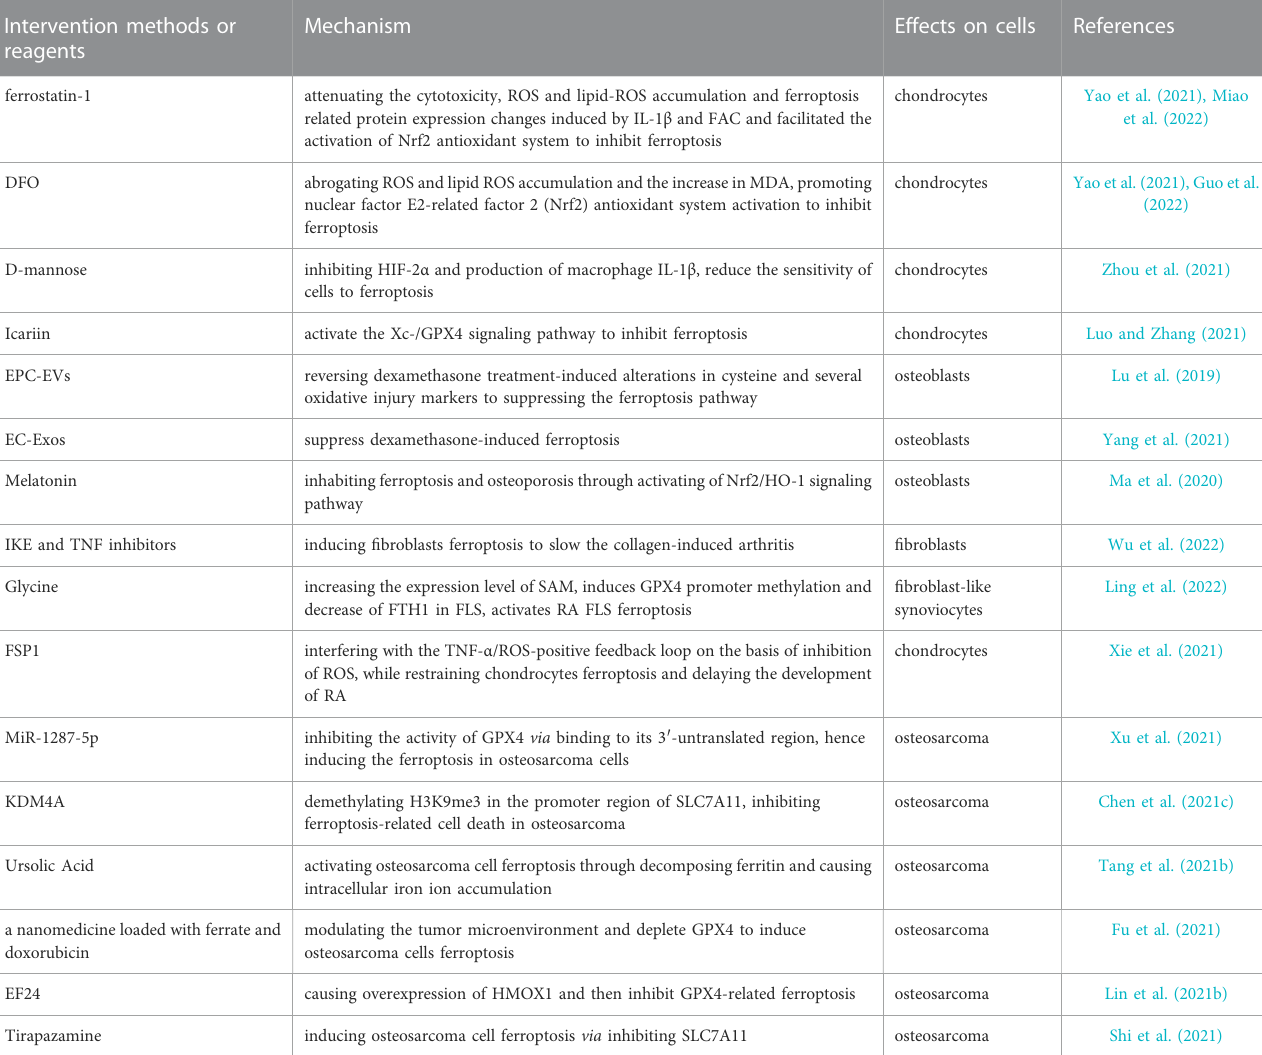
TABLE 3 Interventions and reagents targeting ferroptosis for musculoskeletal